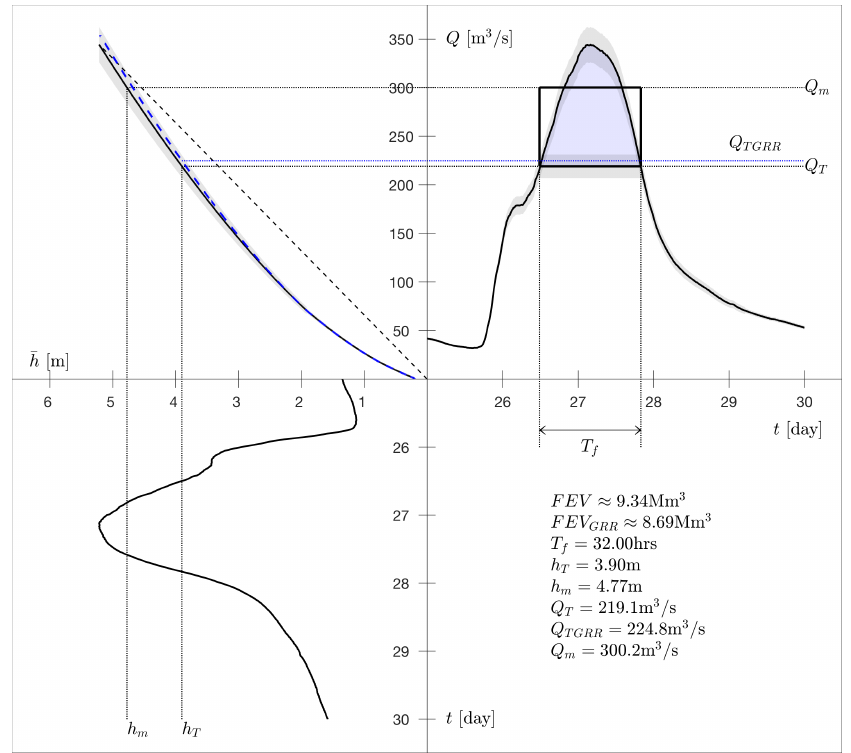
Figure 4. The rating curve including errors (solid line, top-left panel) and its linear approximation (dashed line) are displayed as well as river levels (lower-left panel) and peak-flow rates including errors (top-right panel) of the River Aire at Armley, Leeds, around Boxing Day 2015. Dotted lines indicate a chosen threshold, the corresponding discharge and a mean river level. The flood-excess volume (FEV) is found by determining the blue-shaded “area”, as in (2), under the discharge curve (cid:0) ¯ (cid:1) Q ( t ) = Q ( ¯ h ) = Q h ( t ) displayed on the vertical axis as a function of time t on the horizontal axis. It involves the in-situ river level ¯ h = ¯ h ( t ) as a function of time t above a threshold discharge Q T = Q ( h T ) . Given a rating curve, Q T is fixed once a chosen threshold river level, here h T = 3.9 m, has been provided. The flood duration for threshold h T is T f = 32 h. The rectangle represents the mean FEV, V e ≈ ( ¯ Q ( h T ) − Q T ) T f = 9.34 Mm 3 /s with the hatched “area” defined in (3). The dashed-line correction to the rating curve concerns giving-room-to-the-river (GRR) or river-bed widening. It leads to a higher threshold Q TGRR with a reduced FEV for the same river-level threshold h T . The grey shading denotes the error in Q due to rating-curve uncertainty (not shown for the GRR curve). Data from